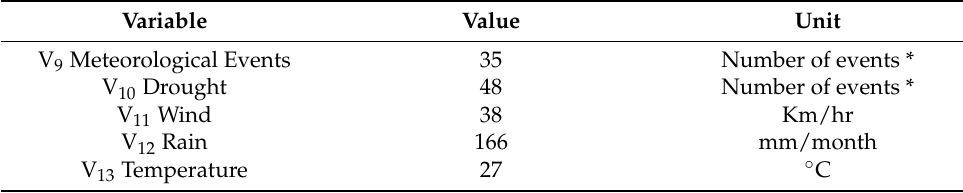
Table A6. Fuzzy model input parameters: uncertain parameters.